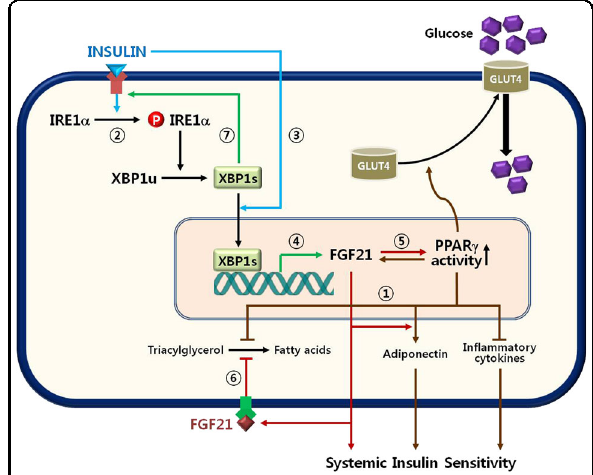
Fig. 7 Schematic illustration of XBP1s-mediated regulation of insulin sensitivity in adipocytes. Accumulating evidence has indicated that PPAR γ is a critical effector of insulin-sensitizing reactions such as GLUT4 translocation, adipokine secretion, and lipolysis ( ① ).